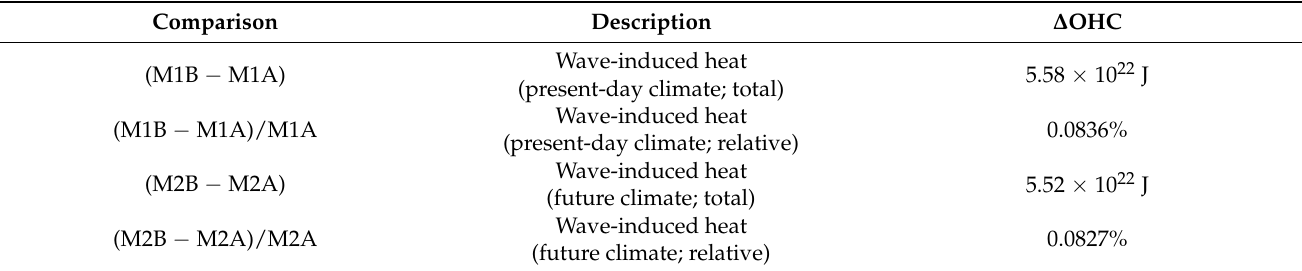
Table 2. Changes in Ocean Heat Content (OHC) due to wave-induced mixing for the present-day and future climates. OHC is the mean heat content within the upper 200 m of the